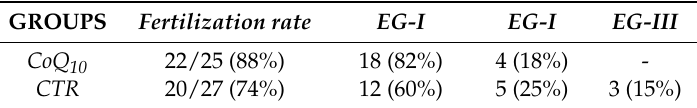
Table 2. Fertilization rate and embryo grading in the CoQ10 group compared to untreated control (CTR). EG-I (Embryo grading I: cells are of equal size; no fragmentation seen), EG-I (Embryo grading II: cells are of equal size; minor fragmentation only), EG-III (cells are of unequal size; no fragmentation to moderate fragmentation).